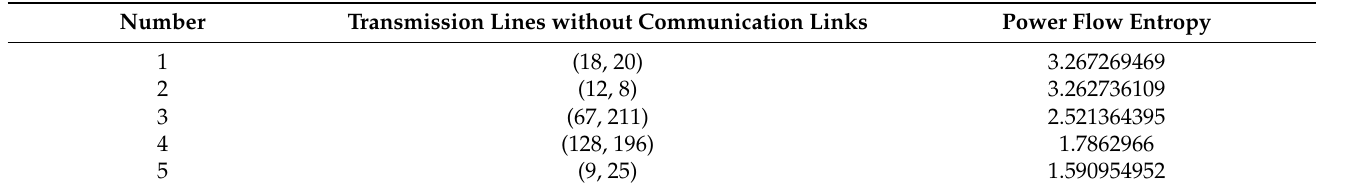
Table 3. The power flow entropy after the cascading failure. Transmission Lines without Communication